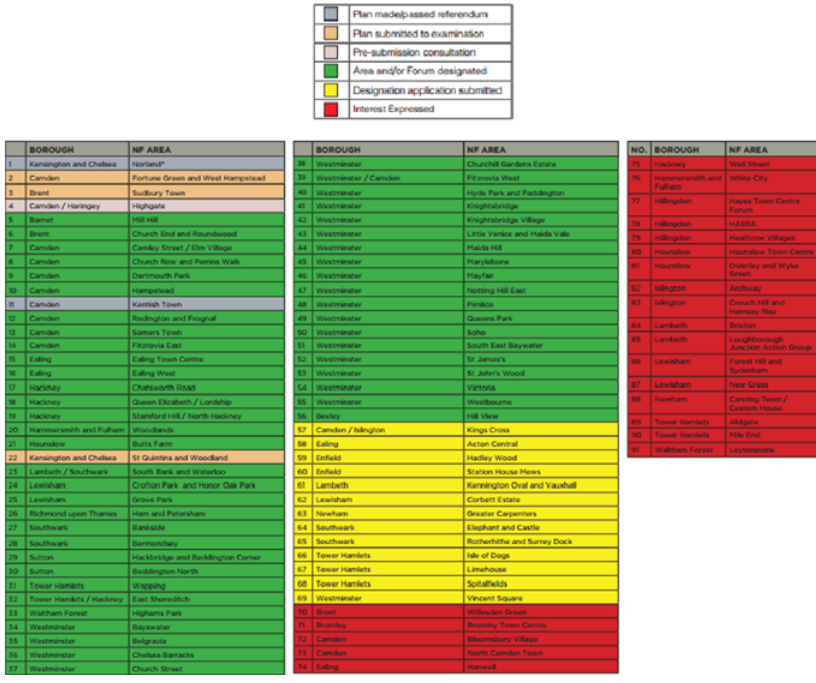
Figure 1. London Neighbourhood Forums, June 2015 (London Communications